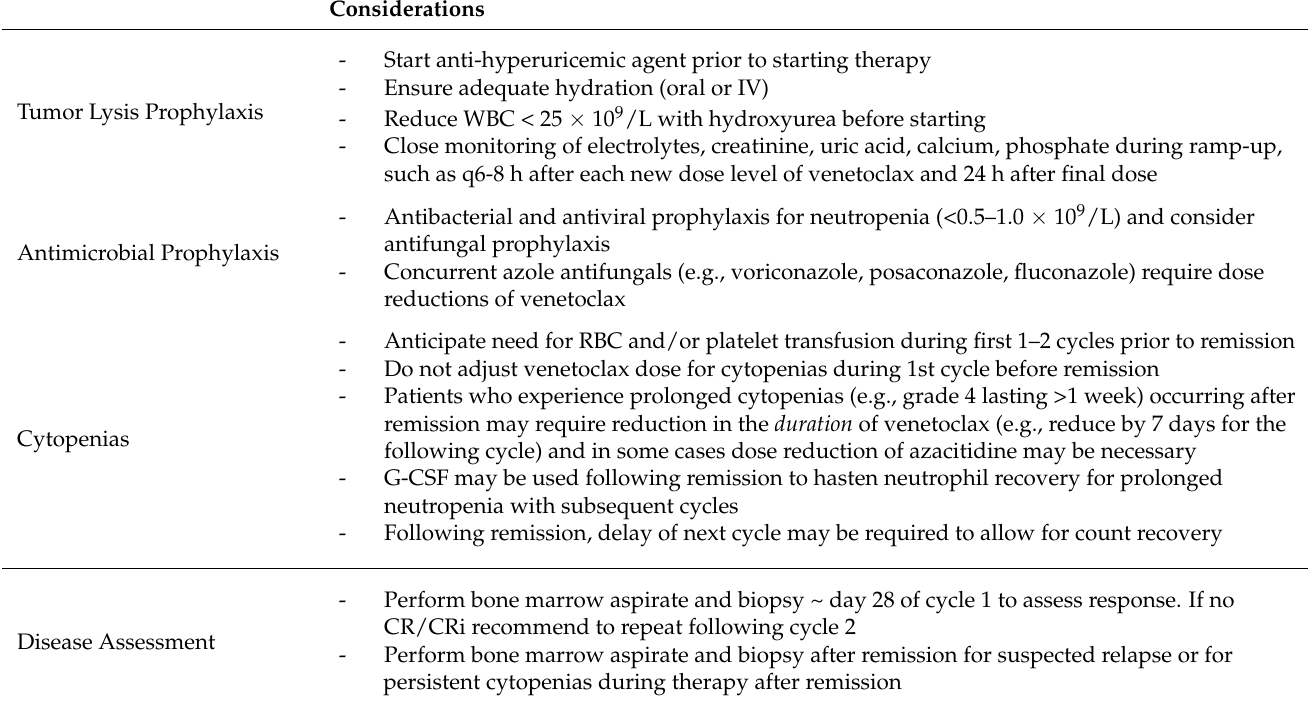
Table 3. Practice points for azacitidine and venetoclax therapy